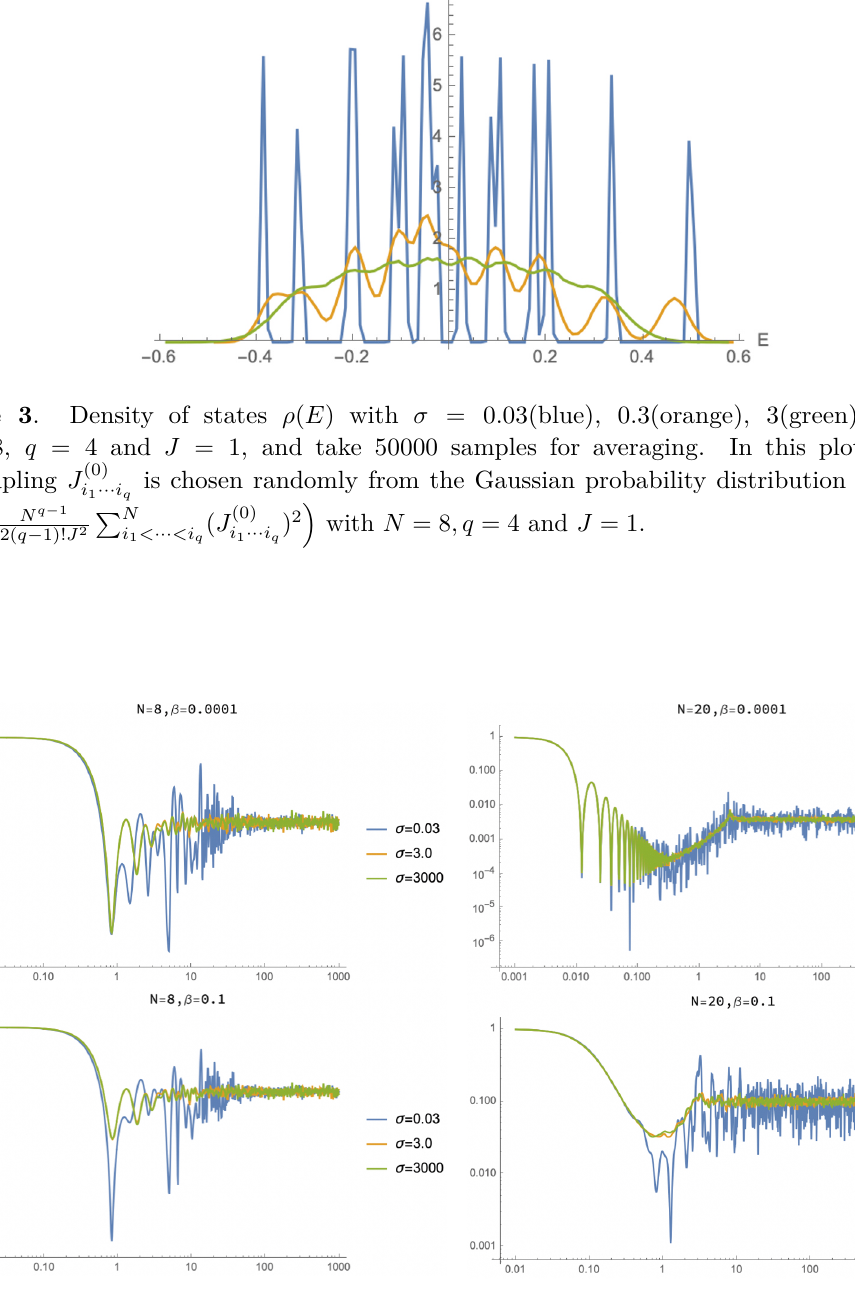
Figure 4 . A log-log plots of the spectral form factors g ( t ) for N = 8 , 20 with inverse temperature β = 0 . 0001 , 0 . 1 for various values of σ . We take q = 4 and J = 1 , and take 100 samples for averaging. We have chosen the same value of the external coupling as figure